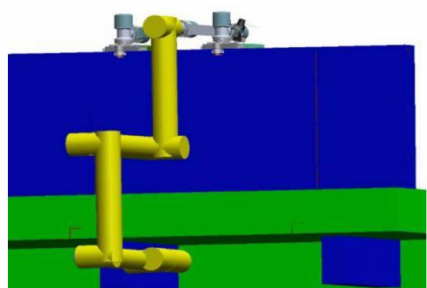
Figure 4. Manipulator and railway bridges simplified as cylinders and cuboids. The minimum distance between typical convex shapes such as cylinders and cuboids can be obtained by the Gilbert-Johnson-Keerthi (GJK) algorithm [28]. The minimum distance between the virtual cylinders and the virtual cuboids is denoted by d min , and the unit direction vector that points from the closest point in virtual cuboids to the closest point C in virtual cylinders is denoted by u. Figure 5 clearly shows that u is the unit gradient direction that causes d min increase at the fastest rate.